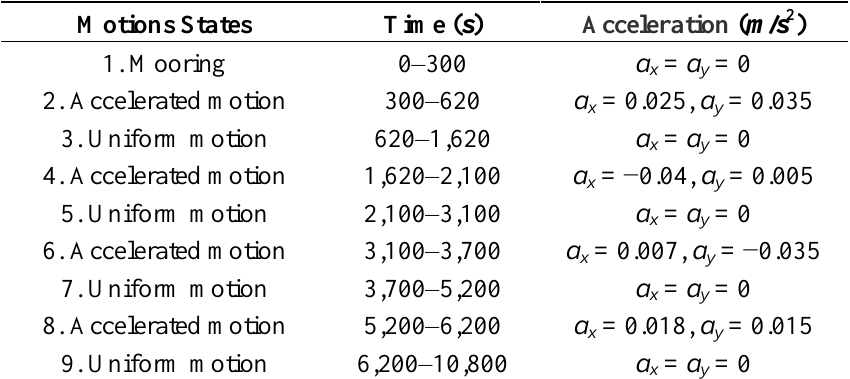
Table 1. Motion states of the marine vehicle.